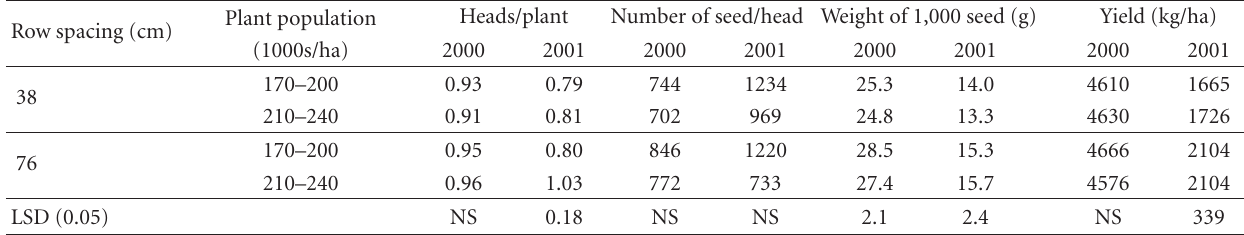
Table 4: Grain sorghum response to row spacing and plant populations under dryland